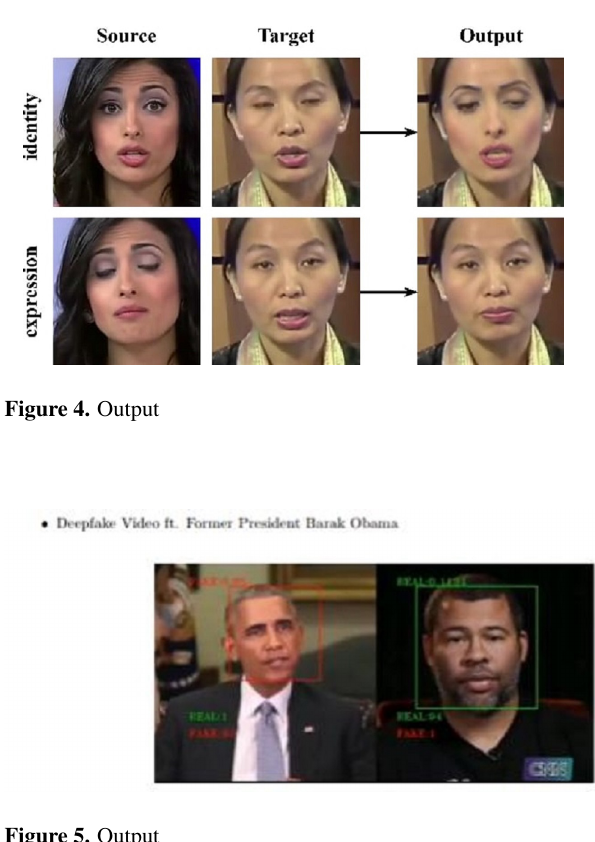
Figure 3. Deep-Fake Detection Challange Dataset [4]